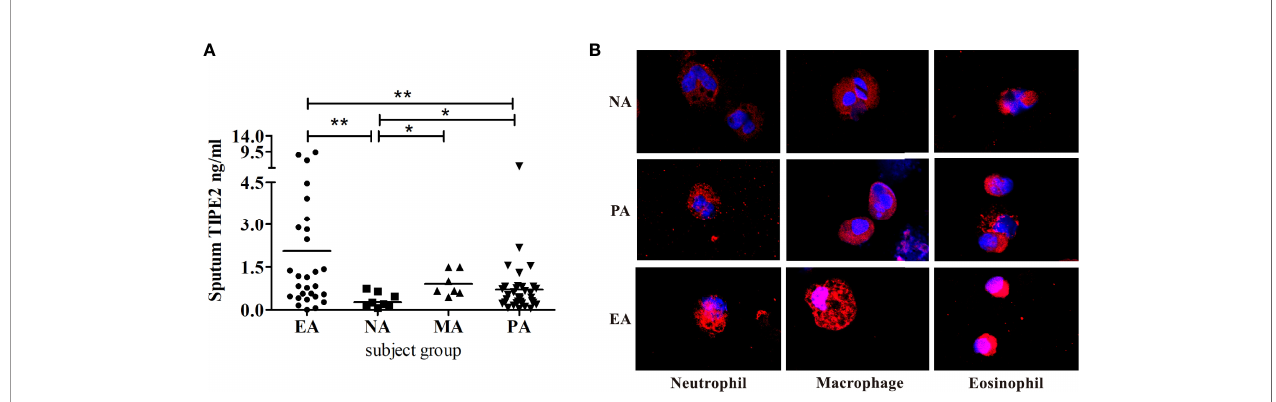
FIGURE 1 | (A) Induced sputum concentrations of TIPE2 in the asthma in fl ammatory phenotypes. (B) Sputum cells from NA, PA, and EA patients stained for TIPE2 (red); nuclei were stained with DAPI (blue). NA, neutrophilic asthma; EA, eosinophilic asthma; MA, mixed granulocytic asthma; PA, paucigranulocytic asthma. *P<0.05,